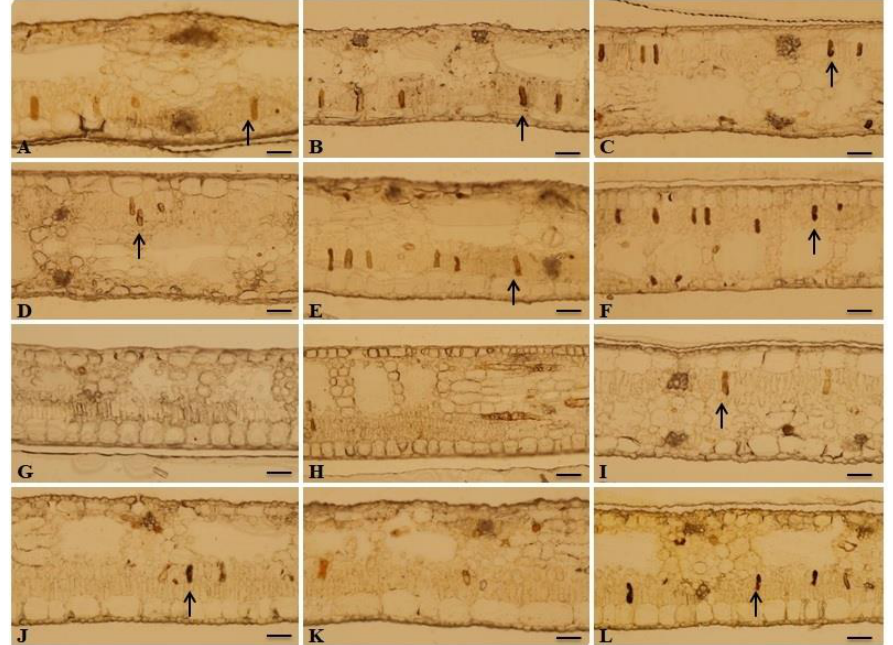
Figure 6. Cross sections of banana leaves of the genotypes Calcutta 4 ( A – C ), Krasan Saichon ( D – F ), Grand Naine ( G – I ), Akondro Mainty ( J – L ) inoculated with P. fijiensis . ( A , D , G , J ) = non-inoculated plants. The images are for 0, 9 and 21 DAI. Histochemical test with ferric chloride for the detection of phenolic compounds . Arrows indicate the production of phenolic compounds. Bar: 200 μm. Cruz das Almas-BA, 2022.